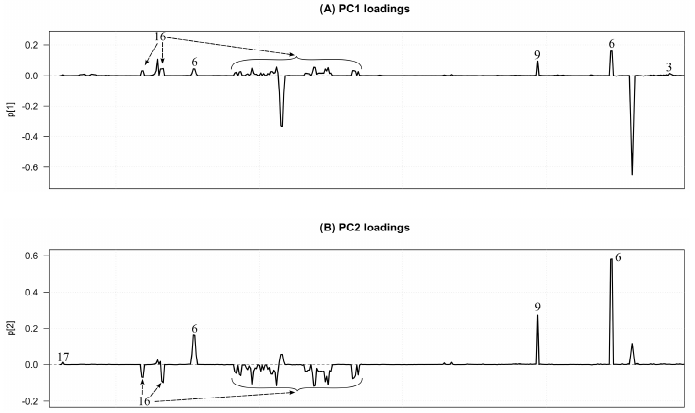
Figure A1. Loading plots of the PCA model of the full E. coli sample set: ( A ) PC1 and ( B ) PC2 loadings with the x-axis reversed to mimic the chemical shift axis of a 1 H NMR spectrum. Significant metabolite and their labels are presented in Table 1.